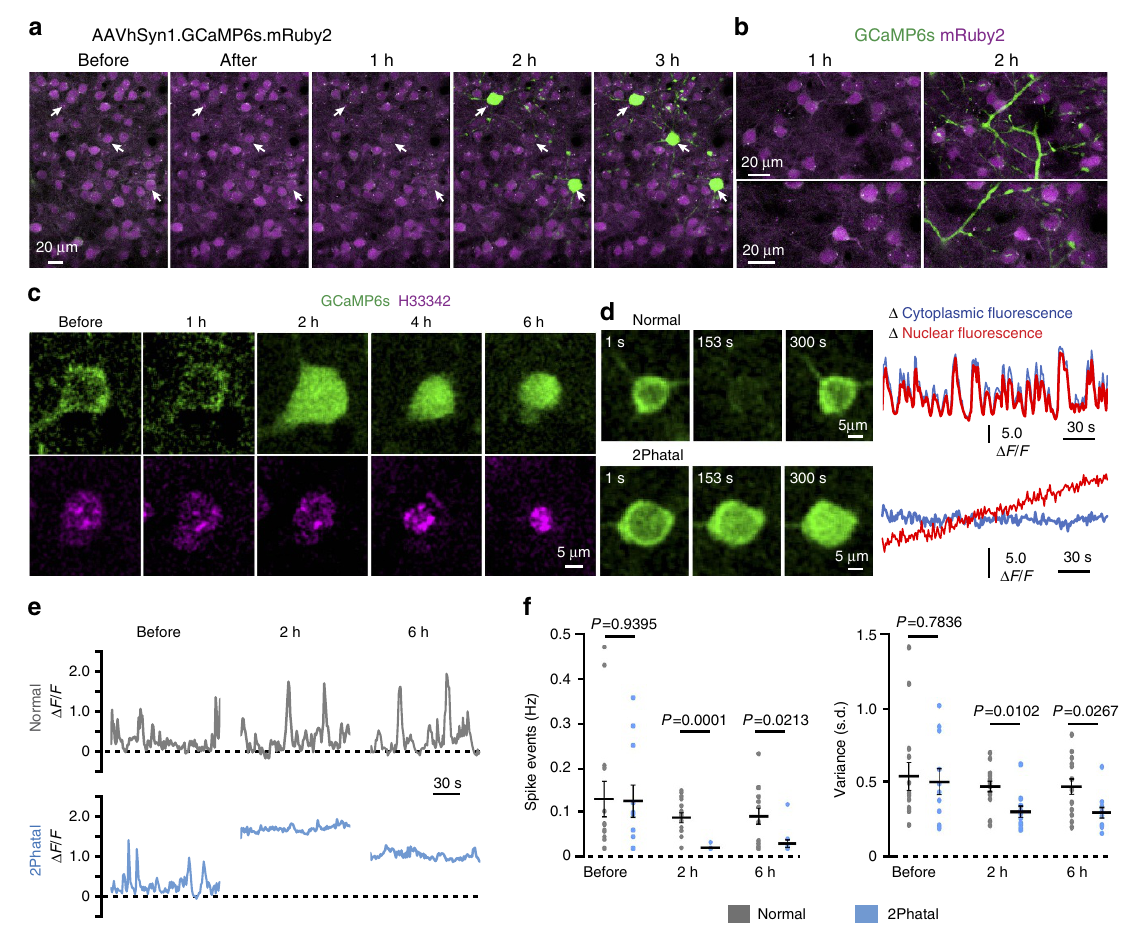
Figure 5 | Temporal course of intracellular calcium changes during apoptosis. ( a ) In vivo time-lapse images of AAV.GCaMP6s.mRuby2-labelled cells in the cortex showing sustained increases in GCaMP6s fluorescence 2–3h after photobleaching of three cells targeted for 2Phatal (arrows). ( b ) Images captured of single dendrites demonstrating sustained calcium increases in cell processes coinciding with calcium increases in soma. ( c ) In vivo time-lapse sequence showing a single neuron targeted for 2Phatal with increases in GCaMP6s signal coinciding with initiation of nuclear condensation. ( d ) Time-lapse sequence showing single images and representative fluorescence intensity traces of nuclear and cytoplasmic GCaMP6s calcium signals in normal and photobleached cells, suggesting alteration in permeability at the nuclear envelope during apoptosis. ( e ) Spontaneous GCaMP6s fluorescence intensity traces from awake head fixed mice at the indicated time points in normal control cells or in cells subjected to photobleaching. ( f ) Left graph showing quantification of the spontaneous frequency of spike events before, 2 and 6h after; significance determined by multiple t -tests with Holm–Sidak correction, before P ¼ 0.9395, t ¼ 0.0767, df ¼ 23; 2h P ¼ 0.000124, t ¼ 5.05, df ¼ 23; 6h P ¼ 0.0213, t ¼ 2.7778, df ¼ 23, as indicated. Right graph